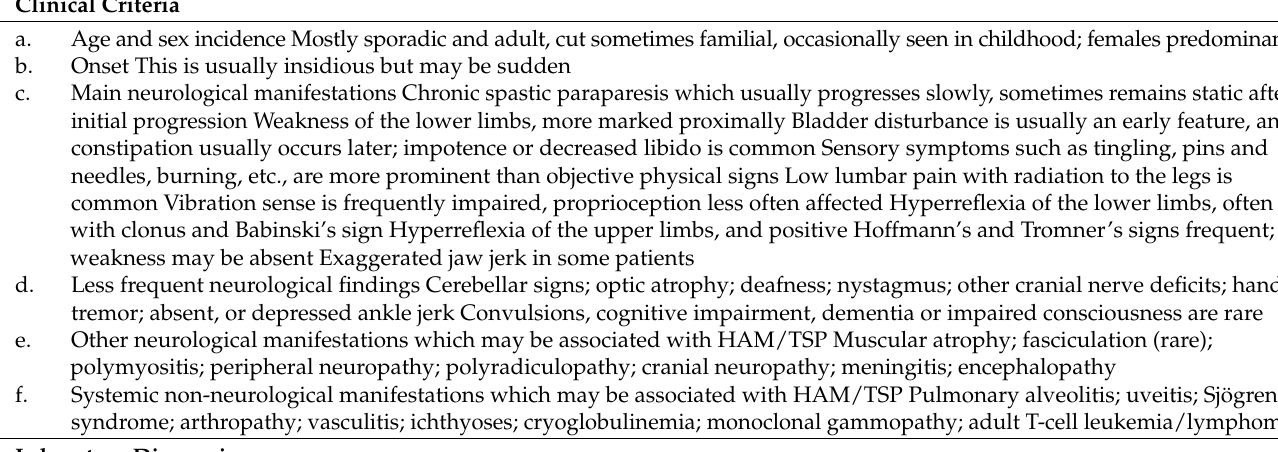
Table 2. World Health Organization diagnosis criteria for HAM/TSP [71,76,77].